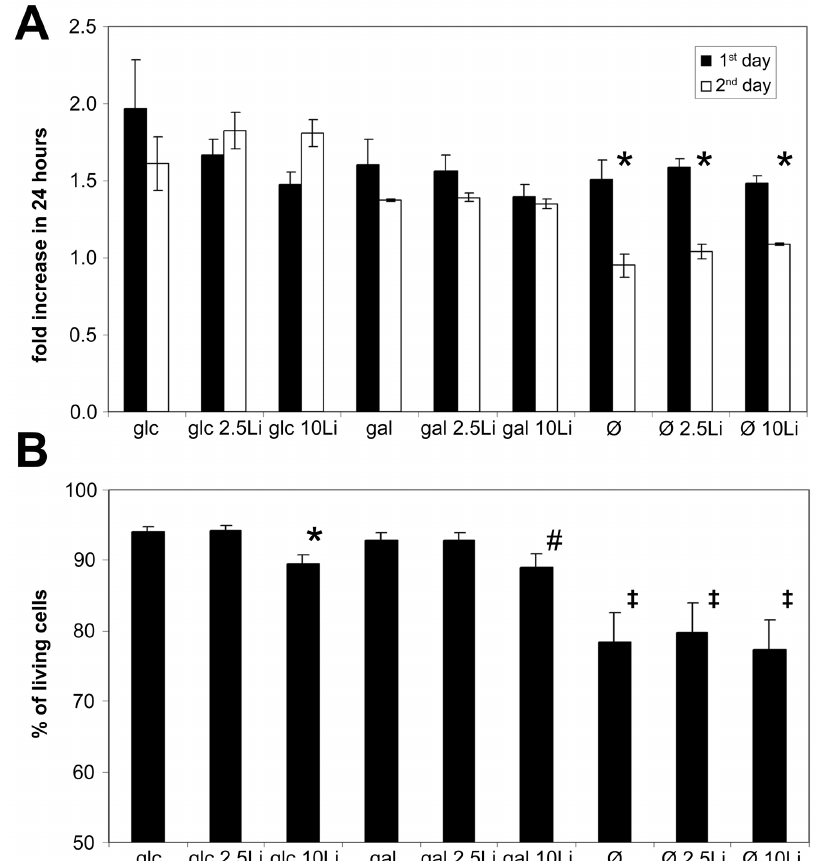
Figure 1. Growth potential of lithium treated Jurkat cells grown on galactose differ from fasting cells. Jurkat cells were incubated in 5 mM glucose or 5 mM galactose containing or hexose-free media for 48 hours. Lithium concentrations were adjusted for each condition at 0, 2.5 or 10 mM. ( A ) Cell counting was performed using an Abbott Cell-Dyn 3700 Hematology Analyzer at 0, 24 and 48 hours of the incubation. Cell growth is expressed as a fold increase during 24 hour periods, measured at day 1 and 2. Data are means 6 SD from at least 4 independent experiments. *P , 0.05 vs. 24 hours earlier. ( B ) Jurkat cells were incubated as described above, after 48 hours the ratio of living cells (Annexin V and propidium- iodide negative) were measured using flow cytometry. Data are means 6 SD from at least 4 independent experiments. *P =0.056 vs. control (glc), # P , 0.05 vs control (glc), ` P , 0.01 vs control (glc).